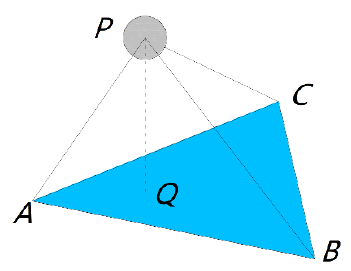
Figure 9. Diagram of ship-ice search model.